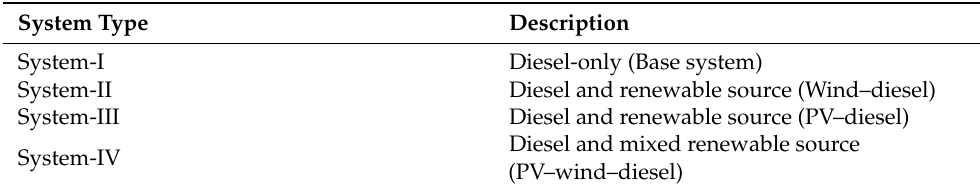
Table 6. Different system types for possible hybrid microgrid development.